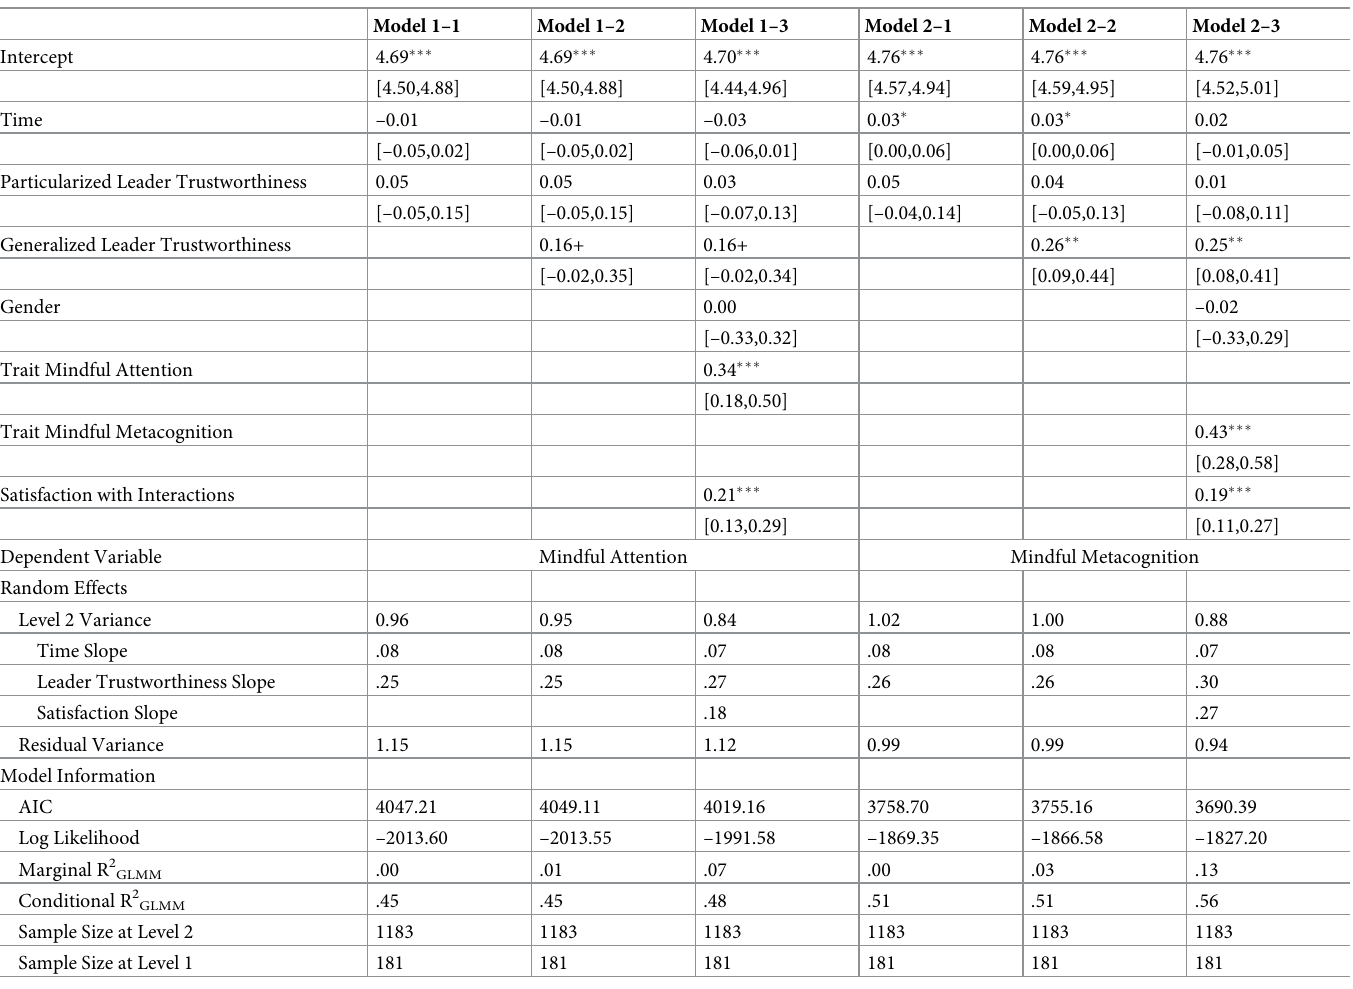
Table 2. Mixed-effects modeling for leader